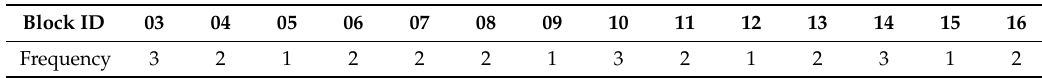
Table 2. Frequency of each block of data based on the example